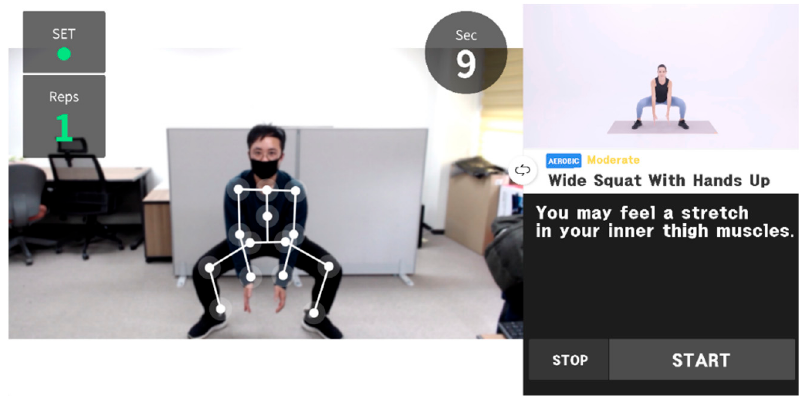
Figure 2. User interface of Weelo. The user’s real-time image and exercise-related data are displayed on the left, and exercise guide images and explanations are displayed on the right.